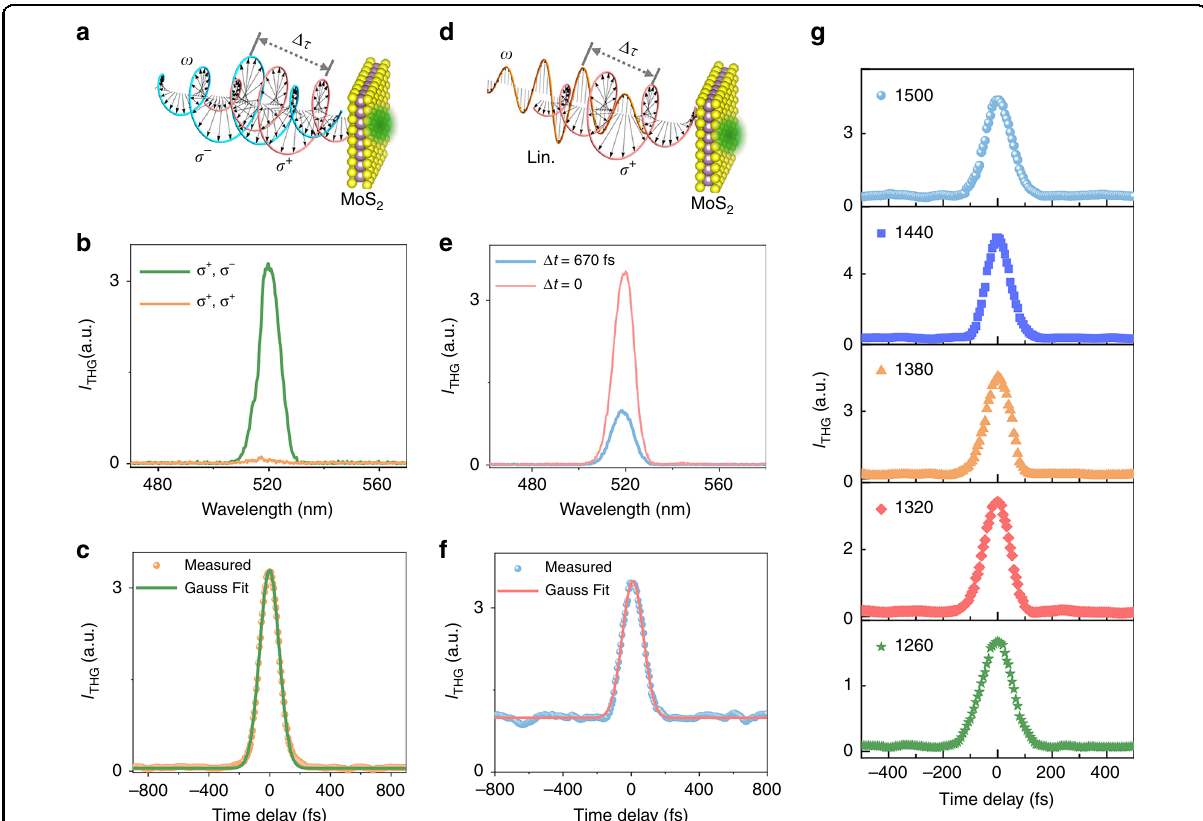
Fig. 2 Coherent modulation of THG in monolayer MoS 2 . a Modulation scheme with two circularly polarized incident beams (Case 1). Purple and yellow spheres in MoS 2 represent molybdenum and sul fi de atoms, respectively. b Measured THG spectra with opposite (green curve) and identical circular polarization (orange curve) states at Δ τ = 0. c Measured THG signal as a function of the time delay for Case 1. d Modulation scheme with a linearly- and a circularly-polarized beam (Case 2). e Measured THG spectra when the linearly- and circularly-polarized beam with (blue curve) and without the time delay (pink curve). f Measured THG signal as a function of the time delay for Case 2. g Modulated THG signal as a function of the time delay with opposite circular polarizations at different wavelengths for Case